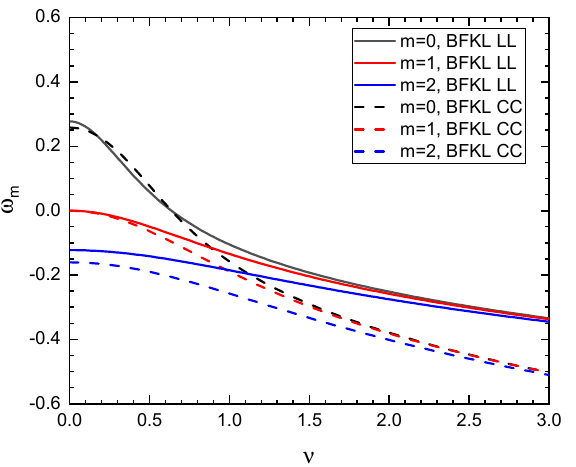
( (cid:23) ) (solid lines) and ! CC ( (cid:23) ) (dashed lines) de(cid:12)ned by eqs. (3.15) m m